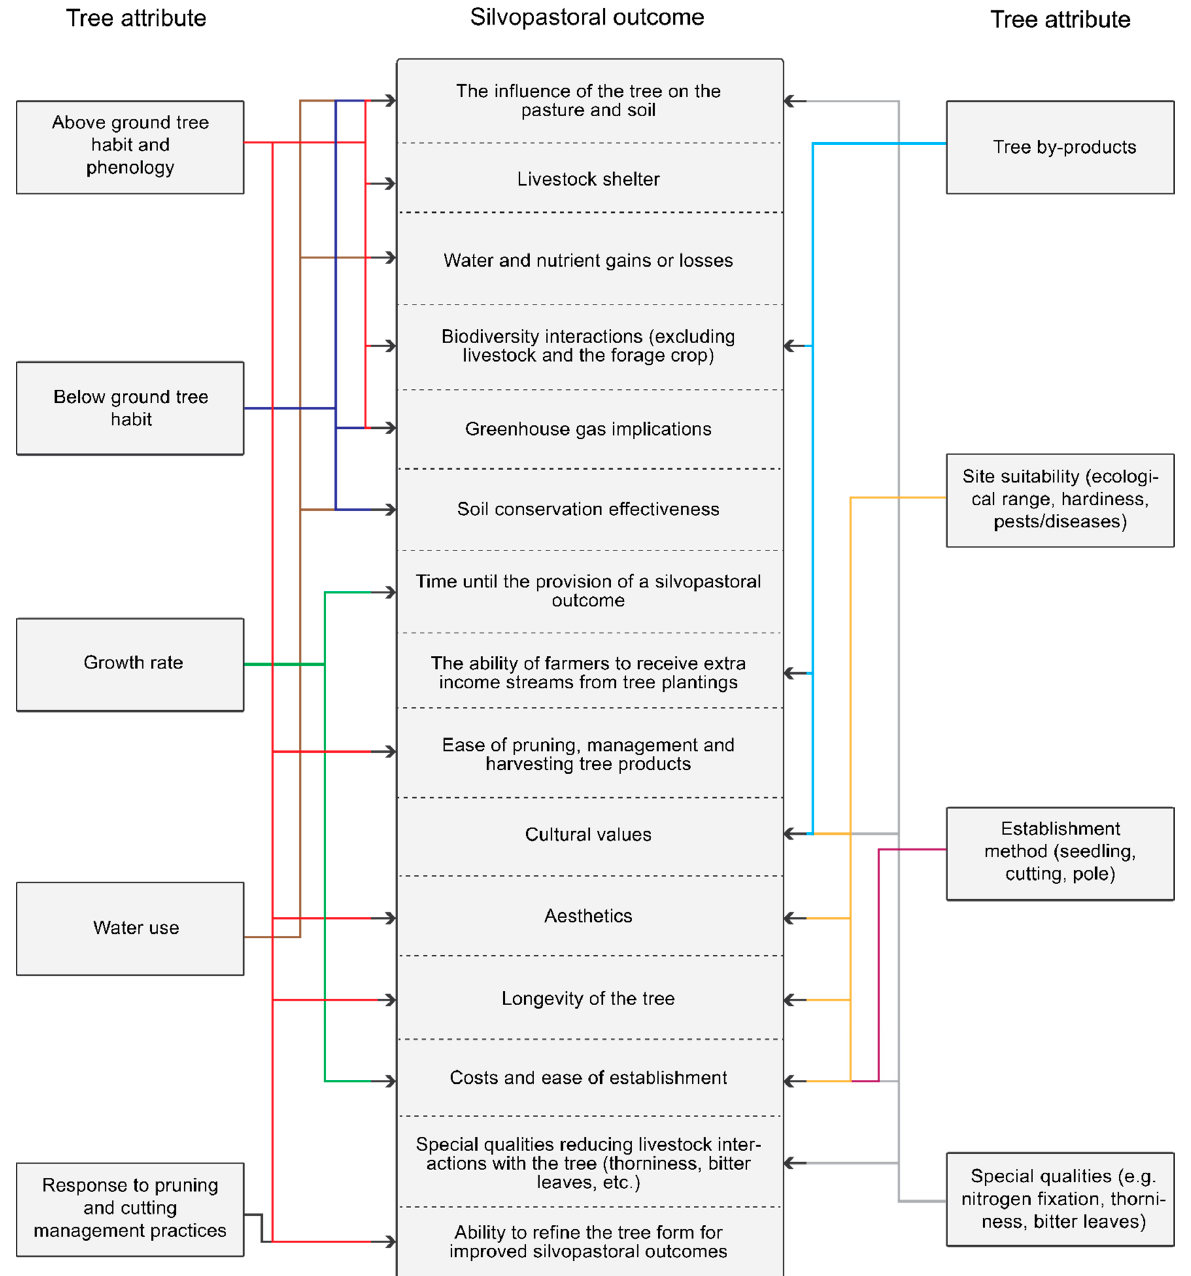
Figure 1. A framework of the interactions within a silvopastoral system between tree attributes and silvopastoral out-